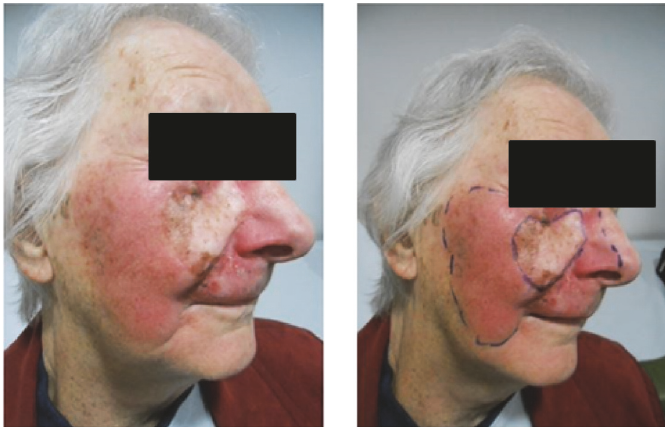
Figure 12: Recurrent LM postsurgery at a dose of 50 of 60 Gy to skin the flap from the lower anterior right neck on face does not get an acute effect. This lady had LM and a large flap to the right medial cheek had failed to clear it. Salvage RT was given. At 50 Gy the surrounding skin is red but the flap is not. The mechanism behind this could be that the flap is relatively hypoxic to the skin and therefore does not exhibit radiation side effects like the normal skin